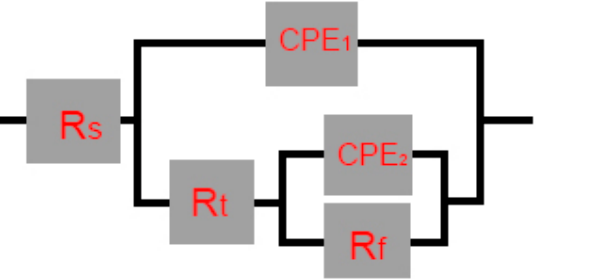
Figure 9. Electrochemical impedance equivalent circuit diagram of surfacing layer in 3.5% NaCl solution. Table 6. Fitting results of equivalent circuit of surfacing layer in 3.5% NaCl solution.